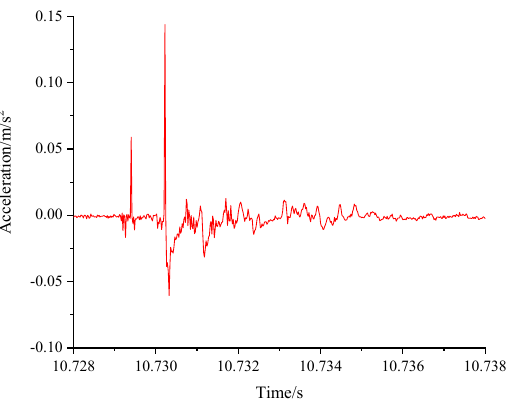
Figure 5. Vibration signal of the nominal operating condition during the auxiliary switch operation.